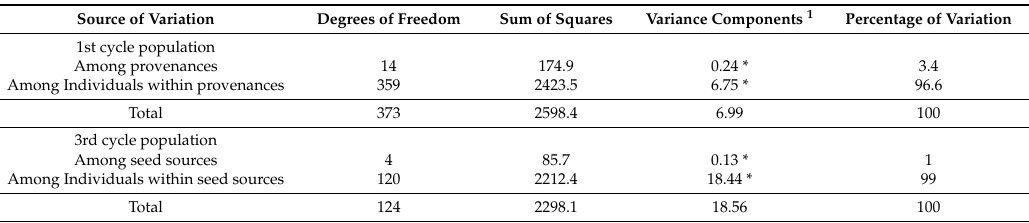
Table 6. Analyses of molecular variance (AMOVA) based on 16 microsatellite loci across: 15 provenances of the first cycle breeding population of E. urophylla that were represented by 5 or more families; and, across the five field trial sources that contributed to the third cycle breeding population of E. urophylla